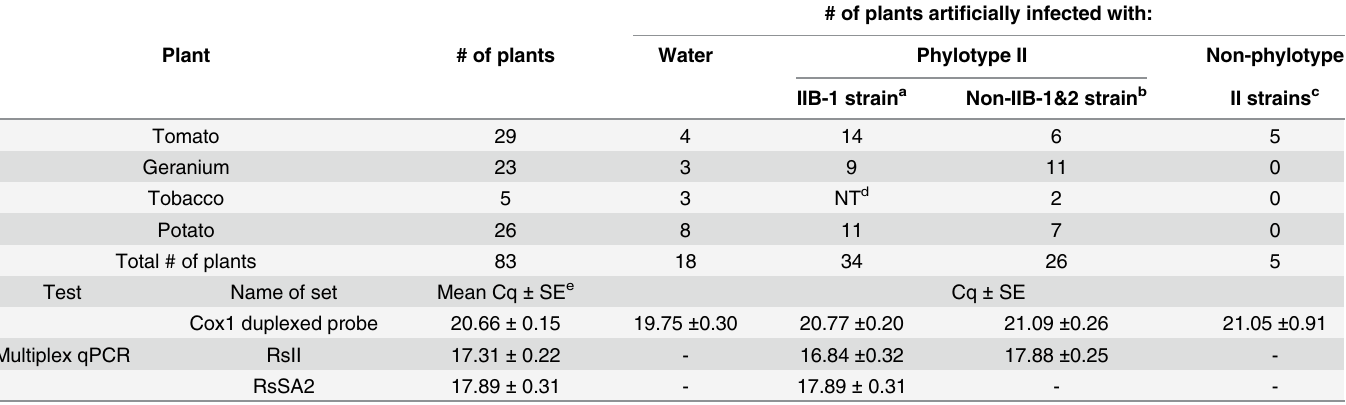
Table 4. Test of symptomatic plants artificially infected with Ralstonia solanacearum strains by our multiplex qPCR assay.